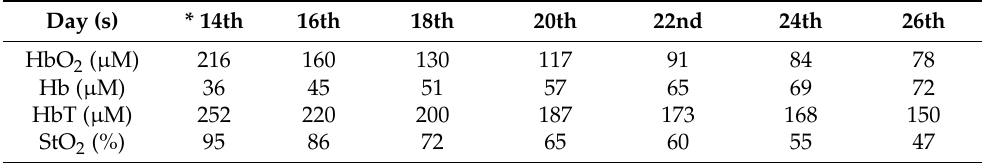
Table 2. Mean changes in intrinsic signals based on time after photodynamic therapy.